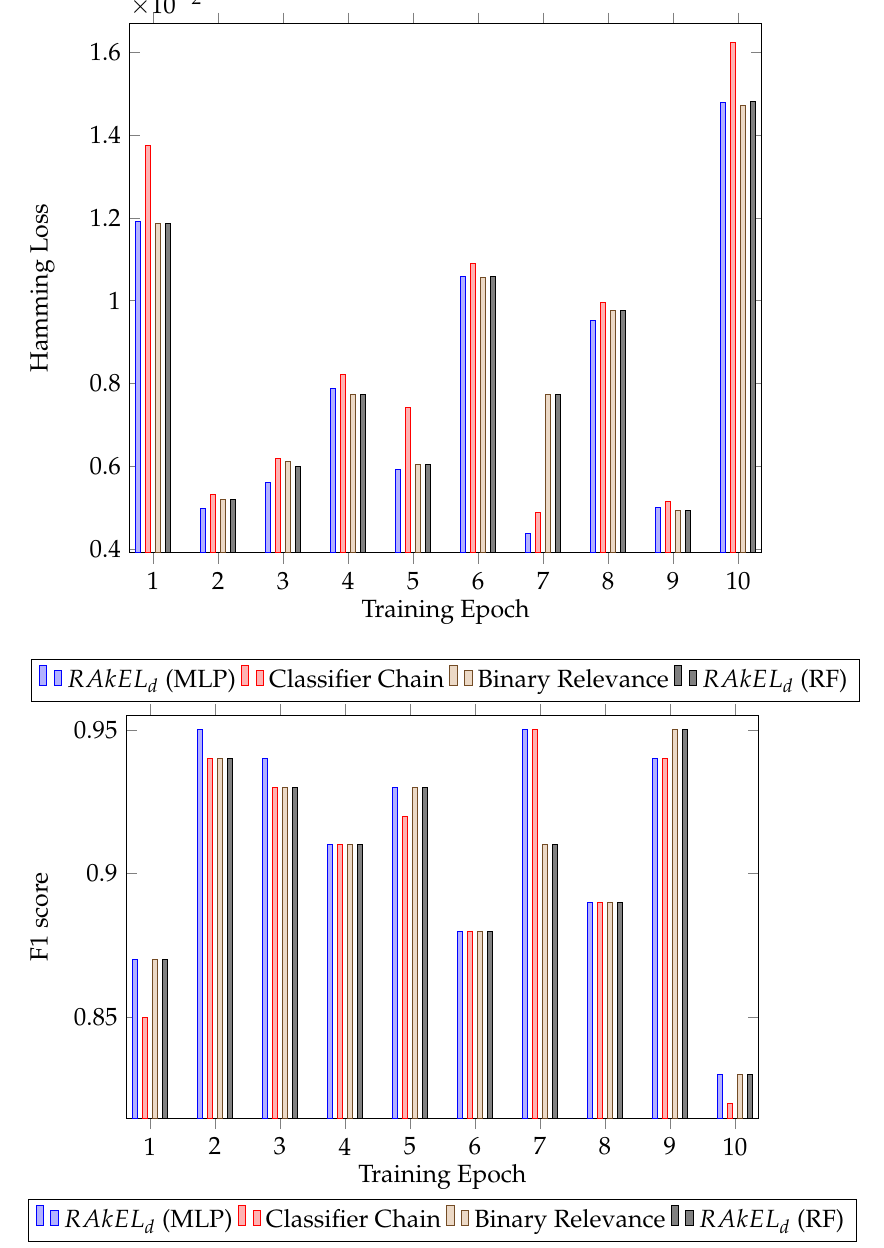
Figure 4. Classification results for House B . Hamming loss for each classifier per validation epoch and F1 score for each classifier per validation